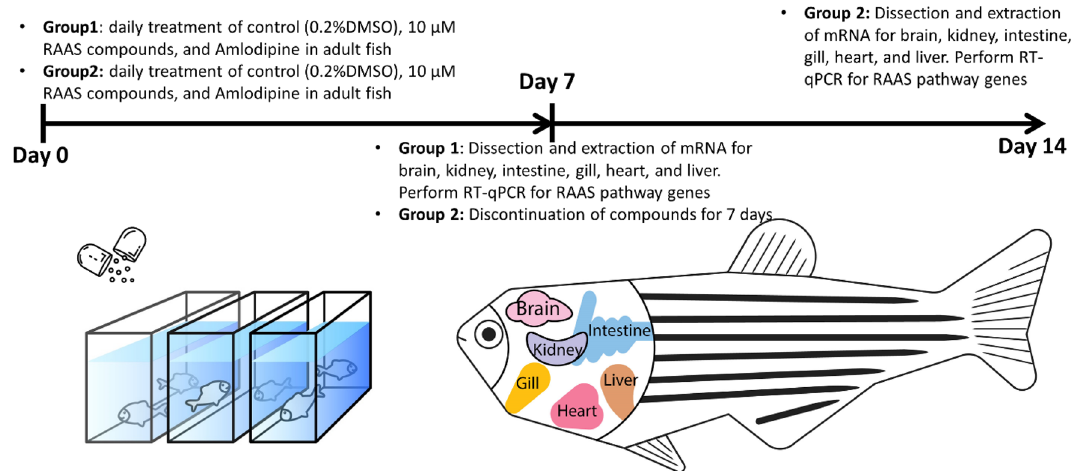
Figure 2. A schematic diagram for the experimental design for drug treatment and discontinuation. To determine mRNA expression of RAAS genes following one week of chronic antihypertensive drug administration, Group 1 consisted of zebrafish that were treated with 0.2% DMSO (control), aliskiren, olmesartan, captopril, and amlodipine daily for 7 days, then dissected for qRT-PCR analysis. Additionally, Group 2 consisted of zebrafish that were treated identically as Group 1 for 7 days, but then drug administration was discontinued for 7 more days before dissection and qRT-PCR analysis. The extracted organs include the brain, kidney, intestine, gill, liver, and heart. Six biological replicates (3 males and 3 females) were used for each compound (or vehicle) in each